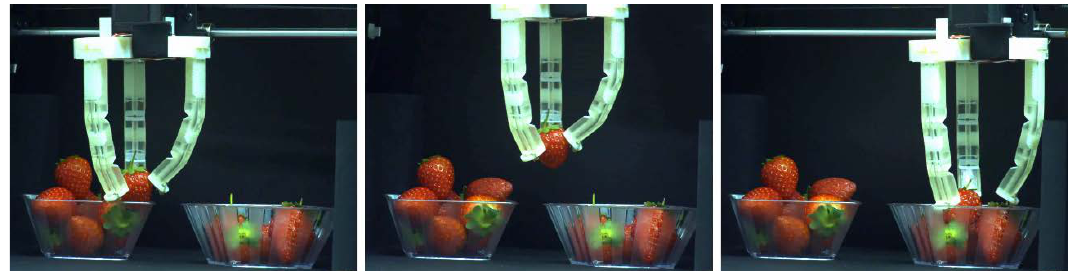
Figure 13. Transferring strawberries from one bowl to another using cable-actuated 3D-printed soft gripper (Video S1 in Supporting Materials).